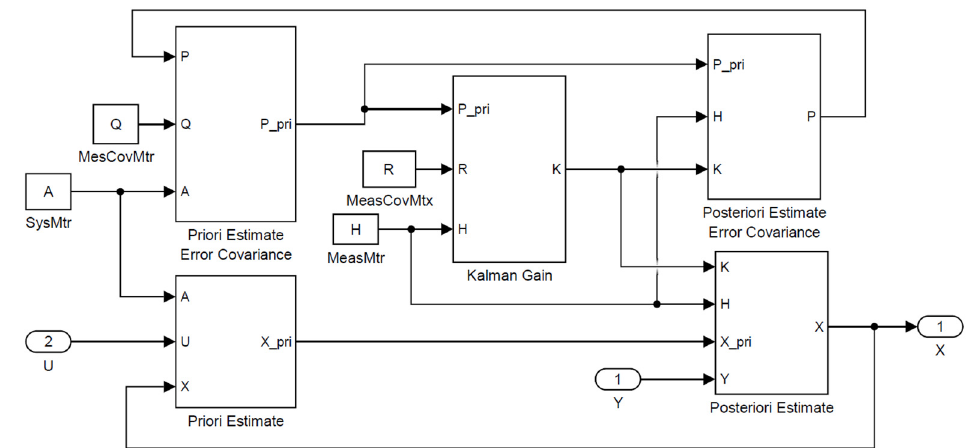
Figure 18. Simulink block diagram of the discrete KF algorithm.